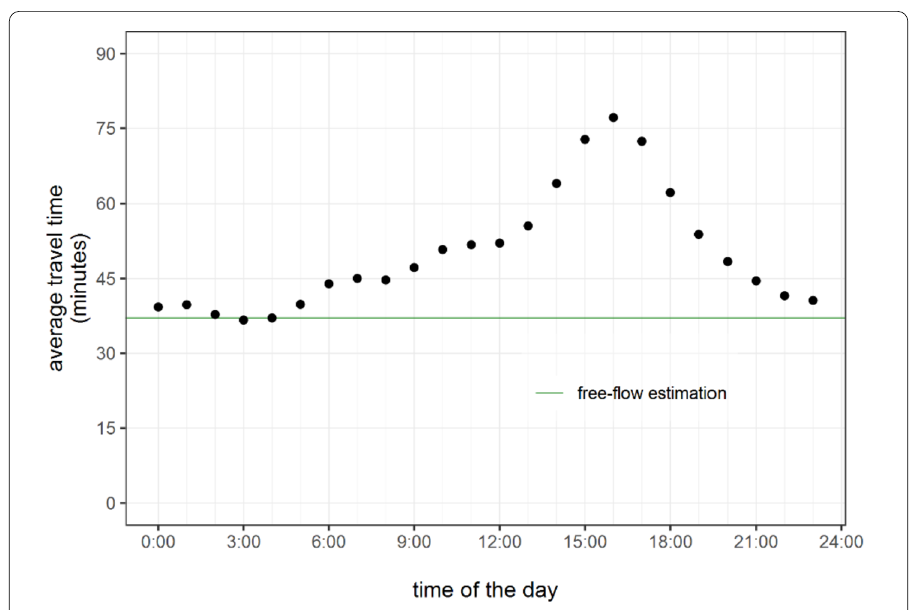
Figure 1 Example of free flow travel time estimation (Chácara Itaim to Aeroporto de Guarulhos—4th quarter of 2018). This figure indicates the average travel time in minutes by hour-of-the for Uber trips originated at Chacara Itaim neighborhood and destined to the International Airport of Guarulhos during the 4th quarter of 2018. The green line indicates the second lowest value by hour and corresponds to the free-flow travel time assumed for this Traffic Zone